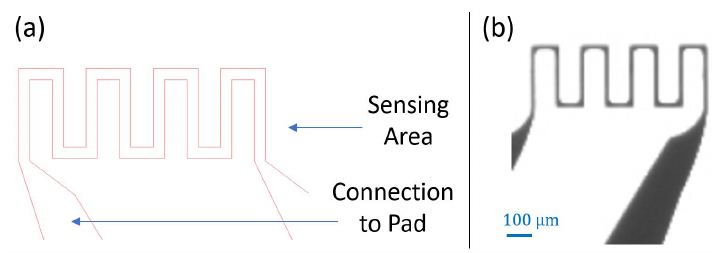
Figure 13. ( a ) Design revision 0.3 ( b ) Micro-fabricated sensor.